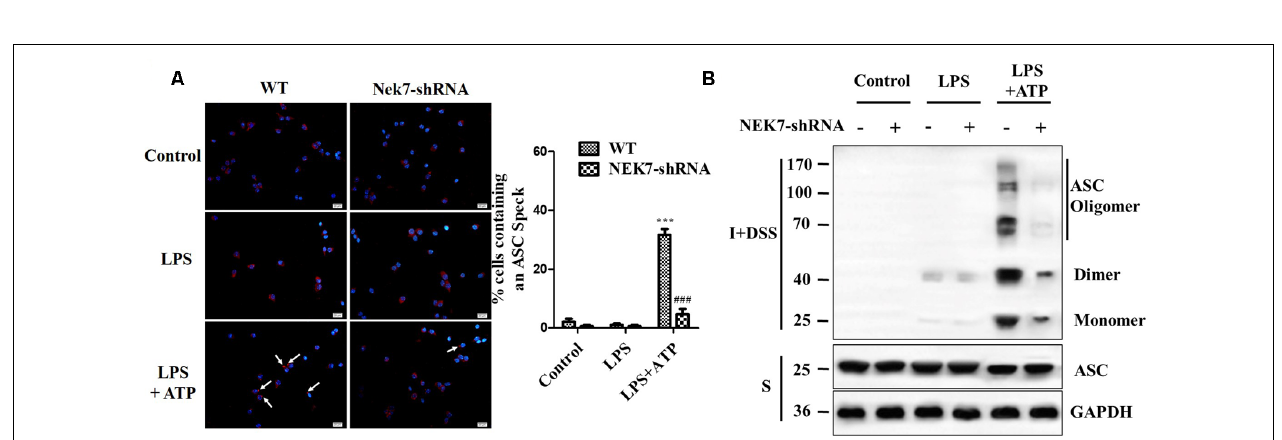
FIGURE 6 | NEK7 is vital for NLRP3-mediated ASC speck formation in primary cortical neurons. (A) Immunofluorescence analysis of ASC specks (arrows) in neurons transfected with NC-shRNA or NEK7-shRNA. Neuros were untreated or stimulated with LPS or LPS + ATP. After treatments, cells were fixed and stained for ASC (red). Nuclear stained with DAPI (blue). Graphs show the means ± SEM, n = 4, more than 100 cells were counted in each test. (B) Cell lysates were solubilized with Triton X-100-containing buffer. Insoluble (I) fractions were cross-linked with disuccinimidyl suberate (DSS) to capture ASC oligomers (I+DSS). The soluble (S) and I+DSS fractions were analyzed by immunoblotting with ASC antibodies. ∗∗∗ p < 0.001, vs. control. ### p < 0.001, vs.